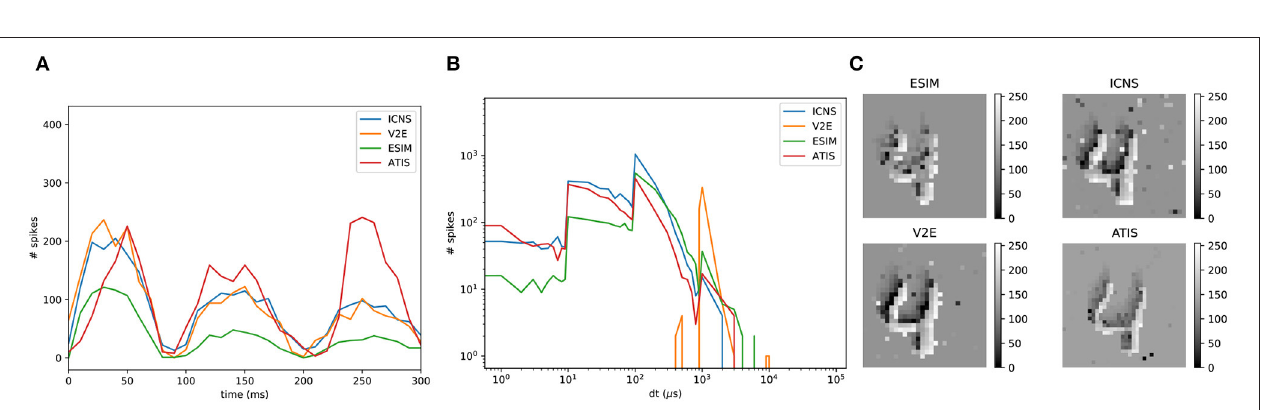
FIGURE 9 | Comparison between a real DVS sensor (ATIS) and the three different simulators. (A) Event rate computed every 10 ms. (B) Histogram of the inter-spike interval. (C) Time surfaces.